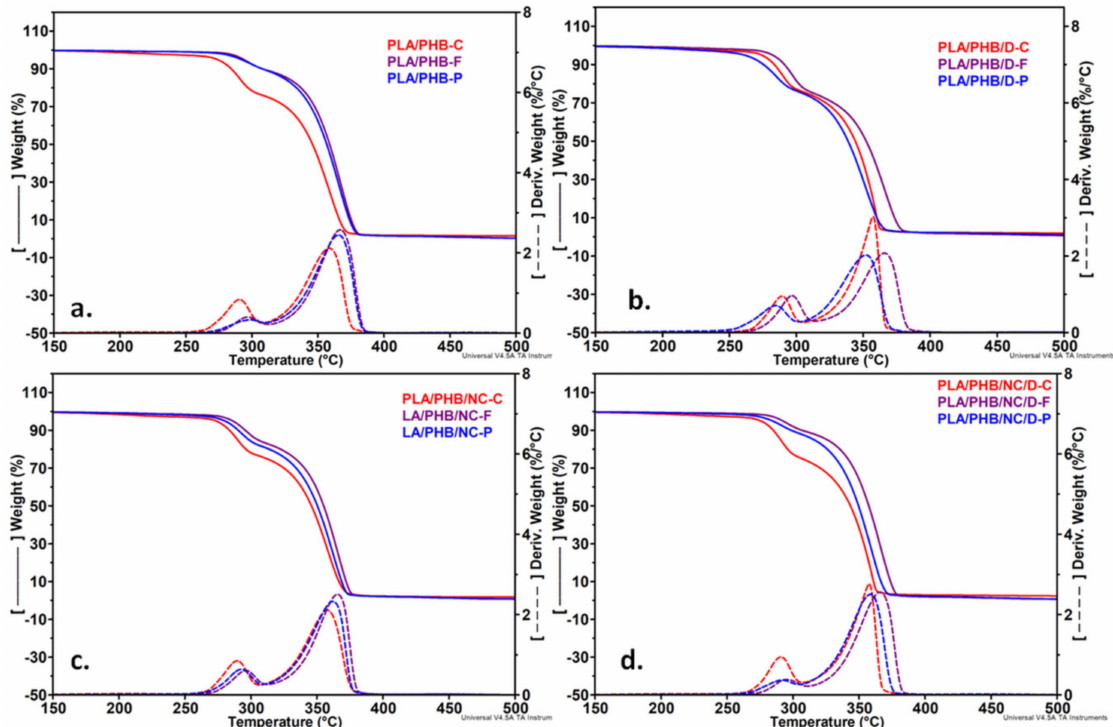
Figure 9. Thermogravimetric curves (TG) and their derivatives (DTG) for uncross-linked ( a ) and cross-linked ( b ) PLA / PHB blends and uncross-linked ( c ) and cross-linked ( d ) PLA / PHB nanocomposites films (C), filaments (F) and printed meshes